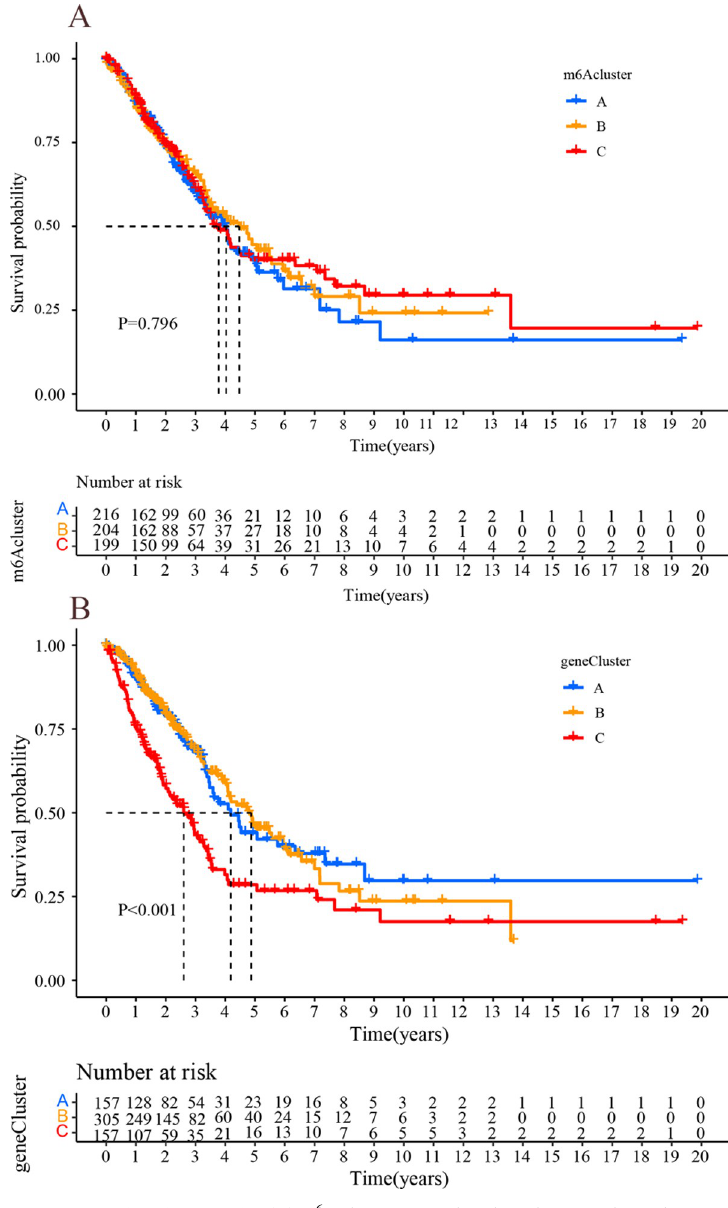
Fig 8. Survival analysis results. (A) m 6 A cluster survival analysis: horizontal coordinates indicate survival time, vertical coordinates indicate survival rate, the blue line indicates cluster A, the yellow line indicates cluster B, and the red line indicates cluster C. (B) genecluster survival analysis:horizontal coordinates indicate survival time, vertical coordinates indicate survival rate, the blue line indicates gene cluster A, the yellow line indicates gene cluster B, and the red gene line indicates cluster